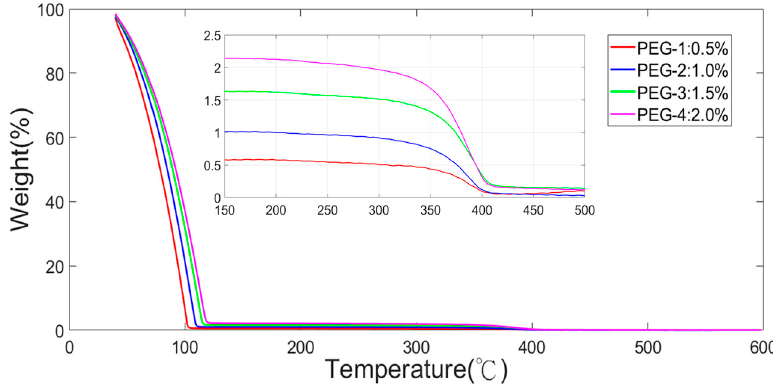
Figure 10. TGA results of four different concentrations of PEG.